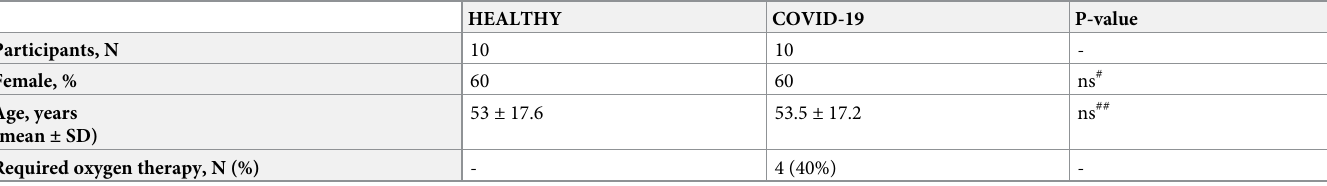
Table 1. Participant details.